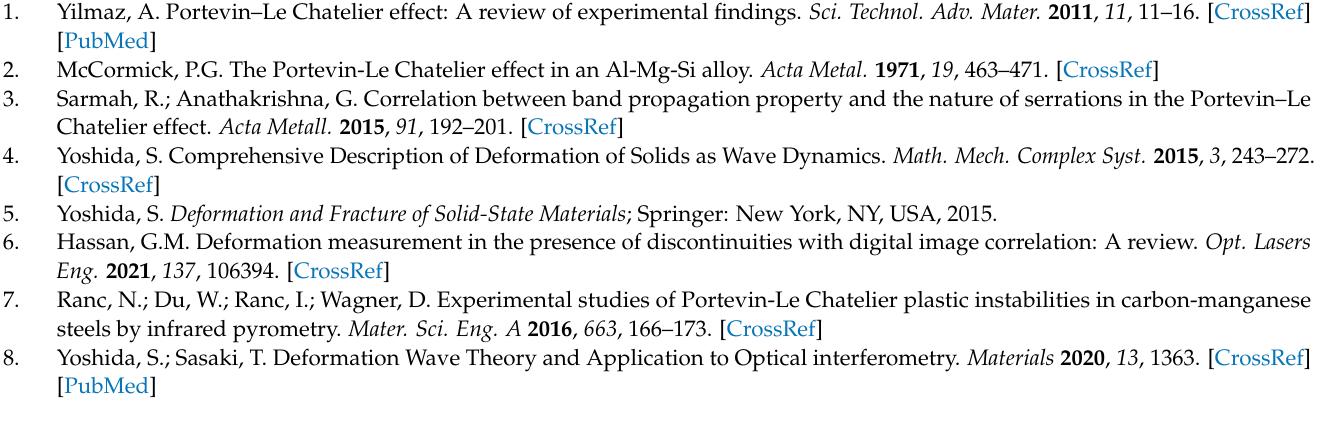
Figure A4. Schematic illustration of difference in optical path.